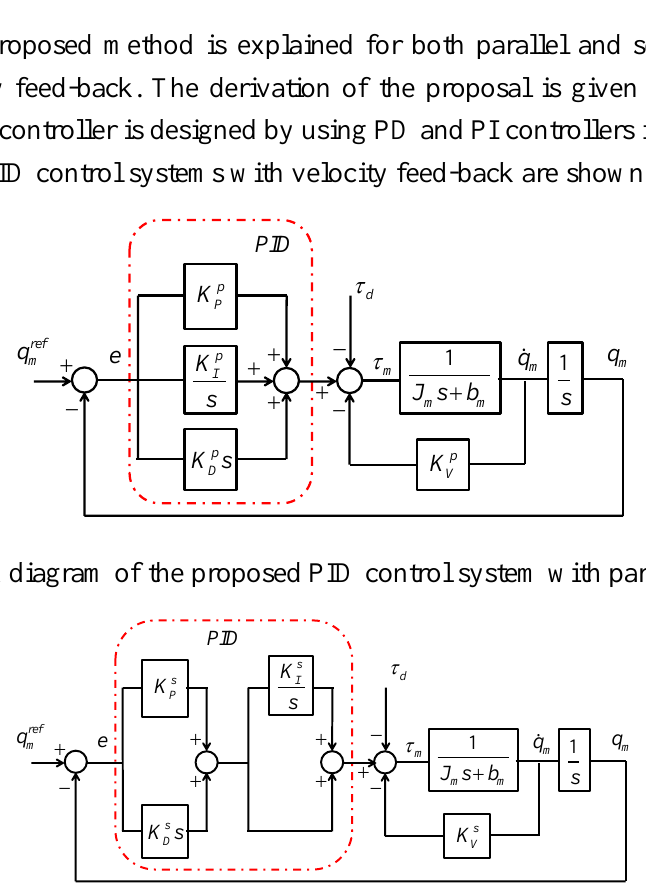
Figure 2. Block diagram of the proposed PID control system with serial